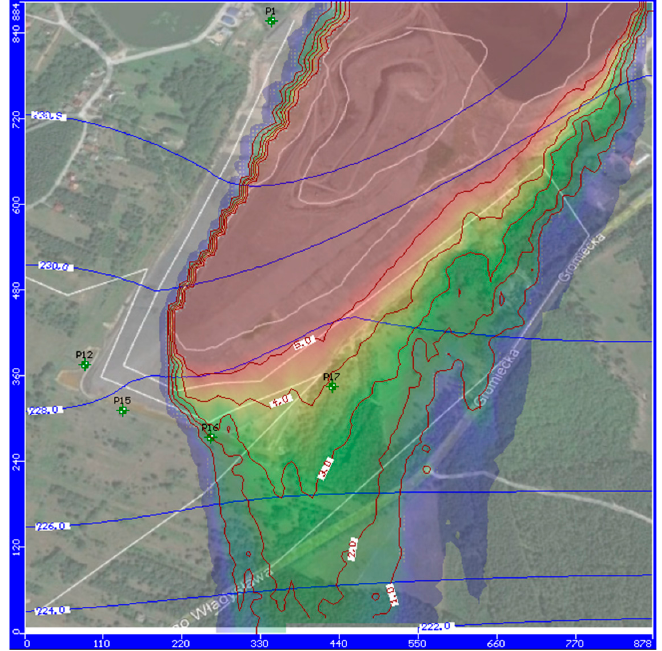
Figure 6. Results of modeling groundwater flow and migration of zinc ions for Q4 2010 (modeling of Zn(II) migration for the steady-state conditions lasted two years). P1, P12, P15, P16, P17—piezometers; numbers in the two blue axes—distance in meters; blue numbers—the height of the groundwater table; red numbers—concentration of Zn(II).